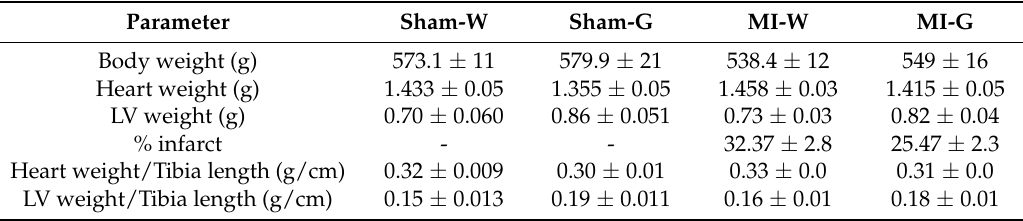
Table 2. Biometrical characteristics of sham and MI animals with and without ginseng berry extract treatment for 8 weeks after coronary artery ligation.